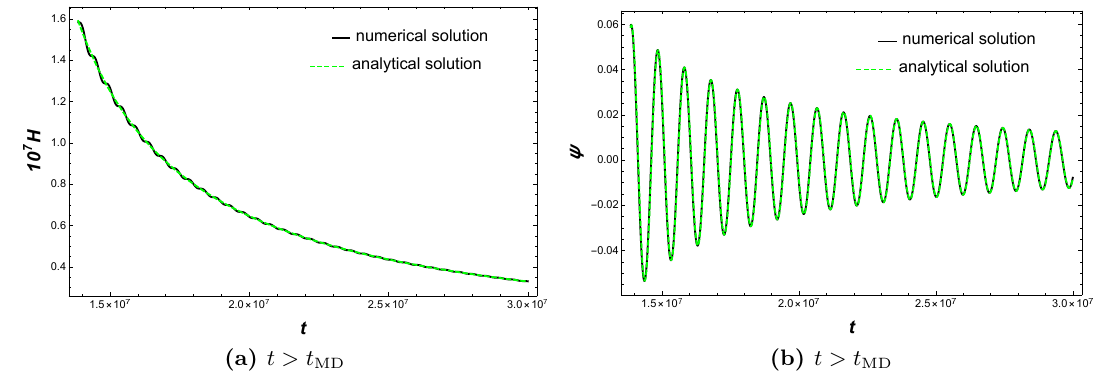
Figure 10. In (a), the black solid curve and the green dashed curve are the numerical solution and analytical solution (4.26) of H ( t ), respectively. In (b), the black solid curve and the green dashed curve are the numerical solution and analytical solution (4.27) of ( t ), respectively. We have